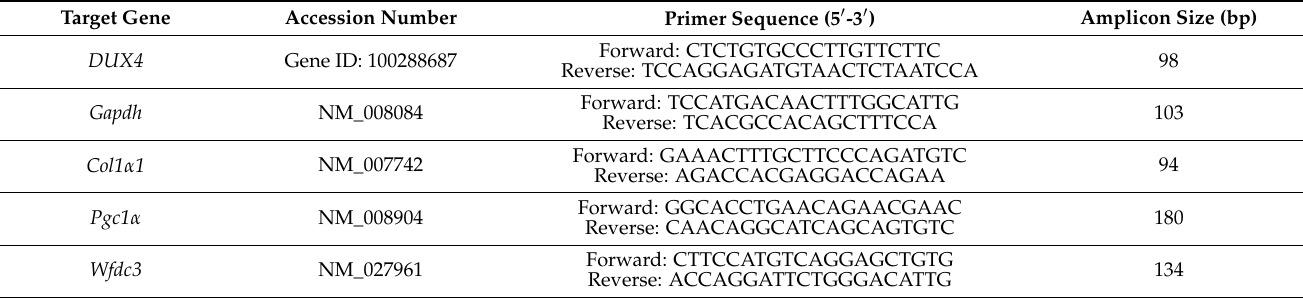
Table 1. Details of qRT-PCR